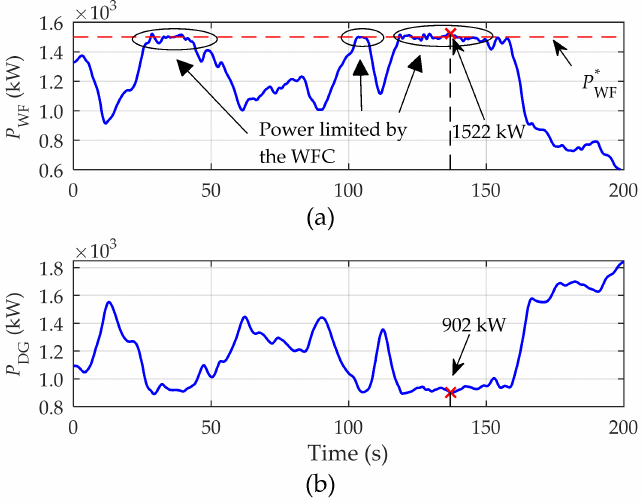
Figure 10. Delivered active power: ( a ) Wind farm; ( b ) Diesel power